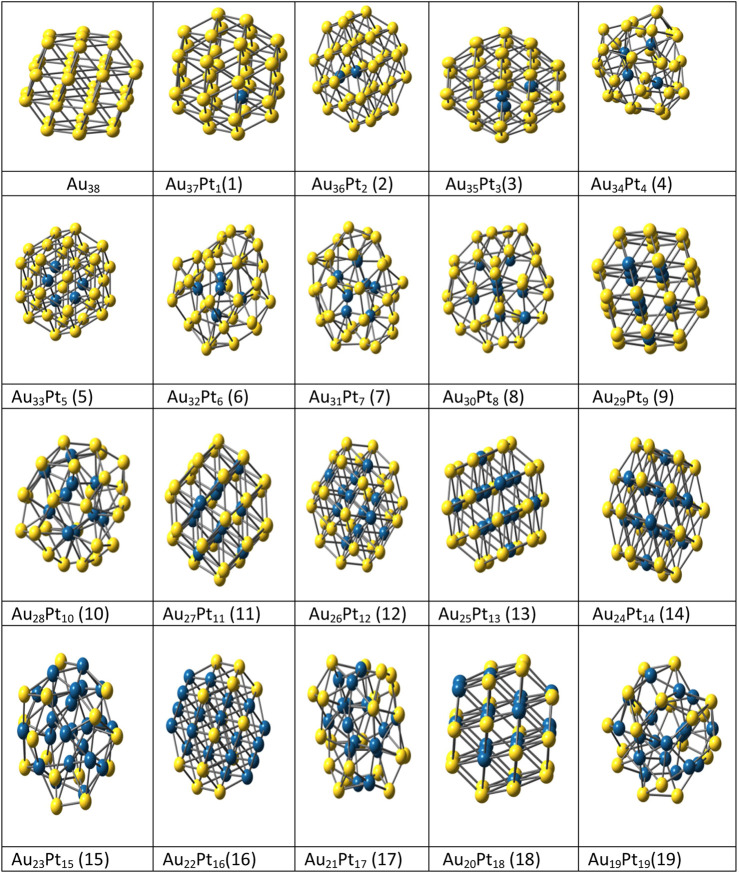
Optimized structures of Au38-xPt x bimetallic (x = 1–19) clusters. (Srivastava, 2018b).